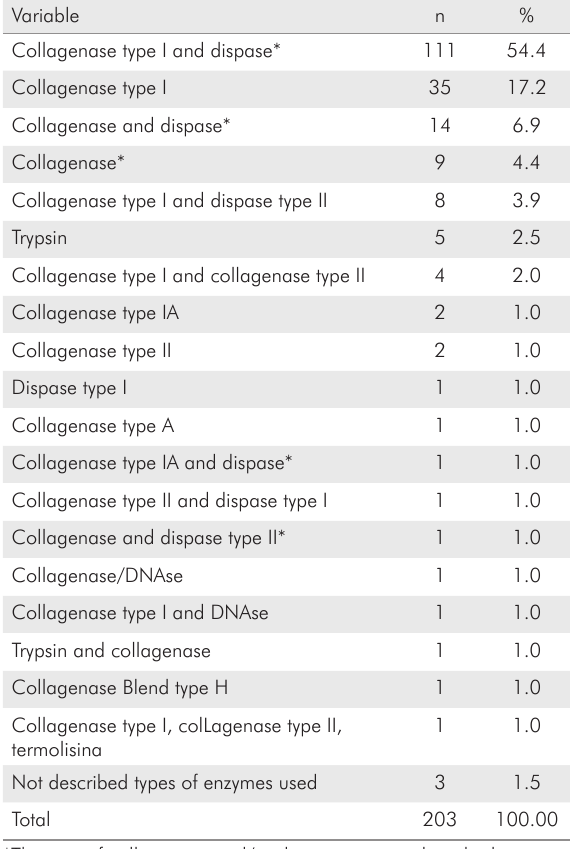
Table 2. Distribution according to the type of enzymes used for DPSCs isolation with the enzymatic technique or in the association of the enzymatic and mechanical techniques.